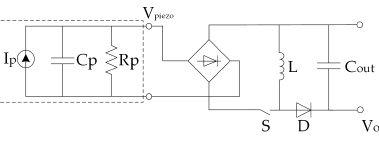
Figure 47. The SSDCI rectifier circuit.